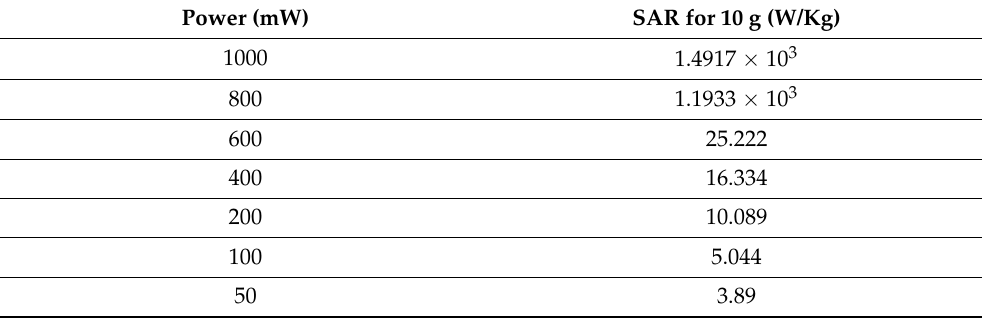
Table 4. Simulated SAR in ten grams of arm tissue obtained from HFSS for the antennas placed at both sides of the human